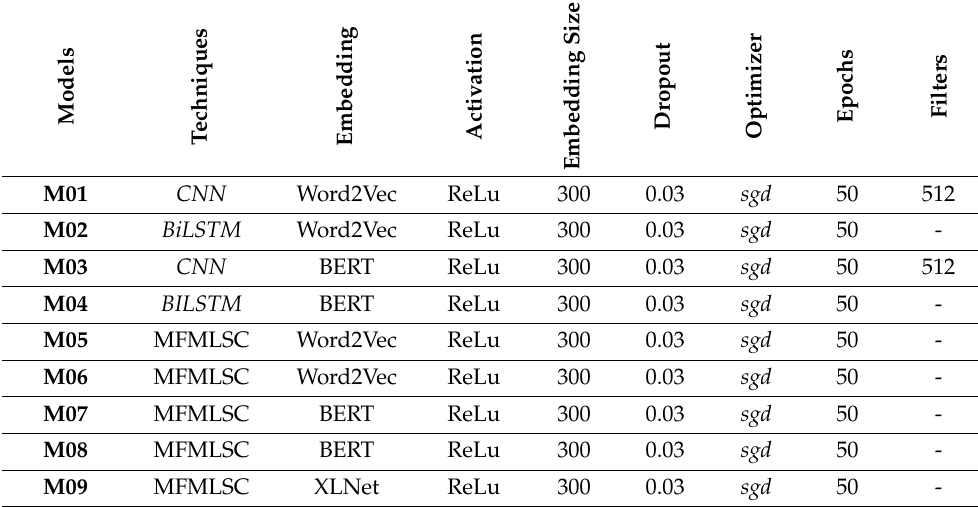
Table 11. Hyperparameters